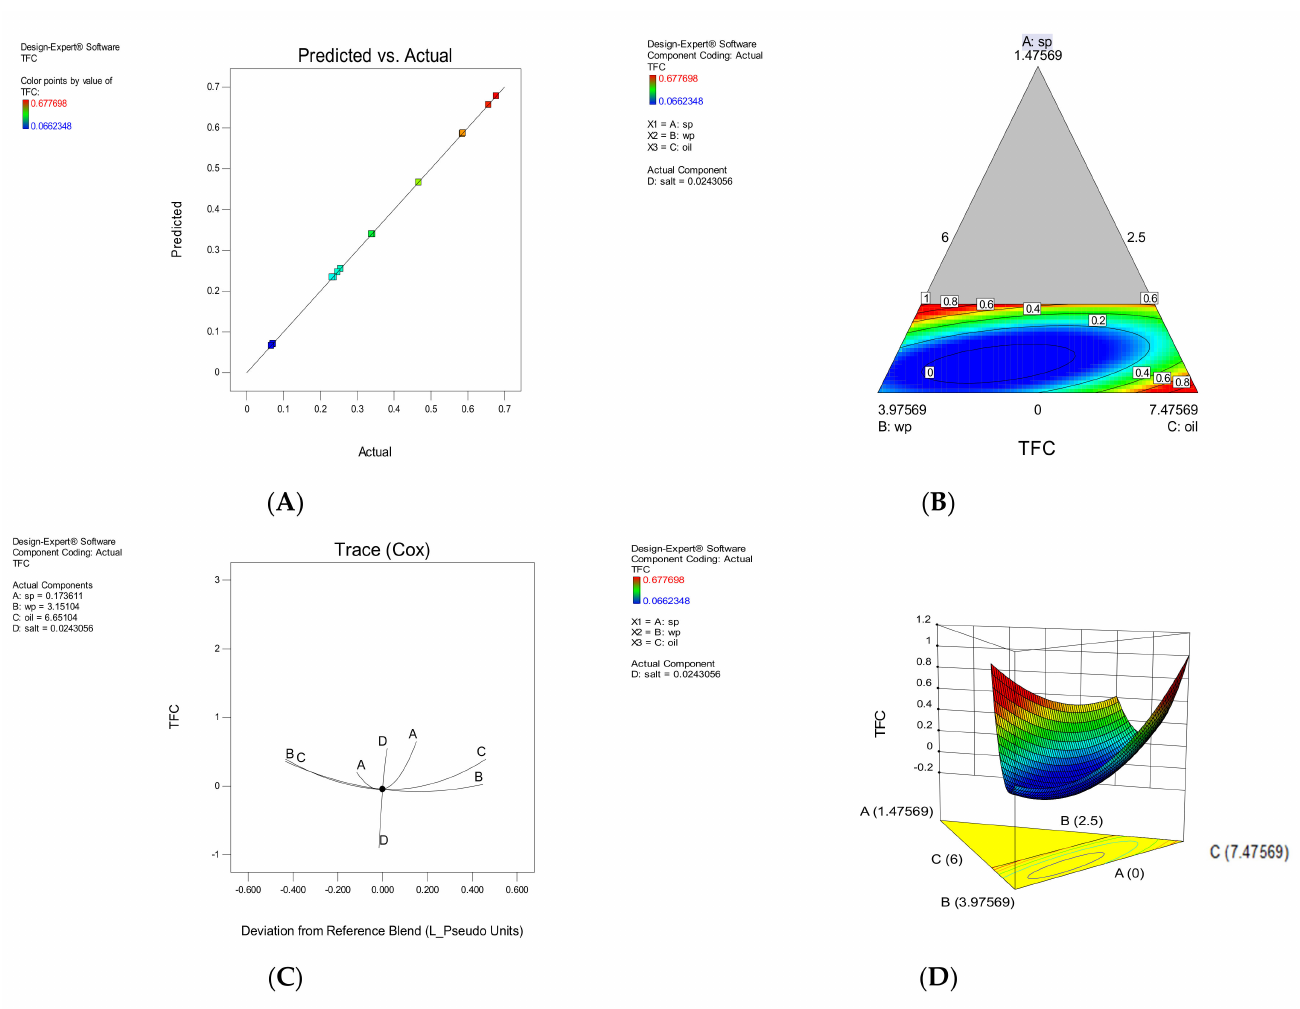
Figure 1. The effect of each parameter on Total flavonoid compounds (TFC), The correlation be- tween experimental and approximated values ( A ), Contour plote ( B ), Trace plot ( C ), response surface plot ( D